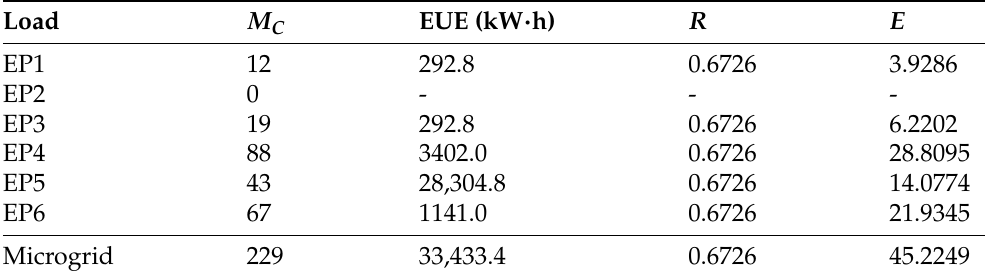
Table 3. Failure scenario summary with current microgrid